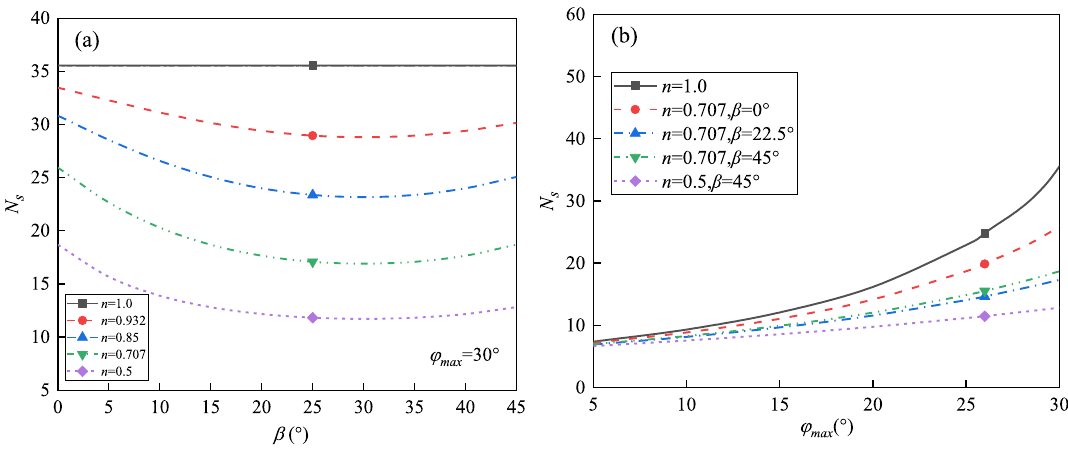
Figure 5. The effects of anisotropic parameters on stability factor (slope angle α = 45°): ( a ) stability factor N s versus β ; ( b ) stability factor N s versus φ max Apparently, F ( θ h , θ 0 ) is a function of parameters θ h and θ 0 , and its minimum value can be calculated using an optimization approach. Based on Eq. (6), the least upper bound of the critical height H c is obtained when the minimum value of F ( θ h , θ 0 ) is obtained. Denoting N s = min F ( θ h , θ 0 ), associating with Eq. (6), we have: